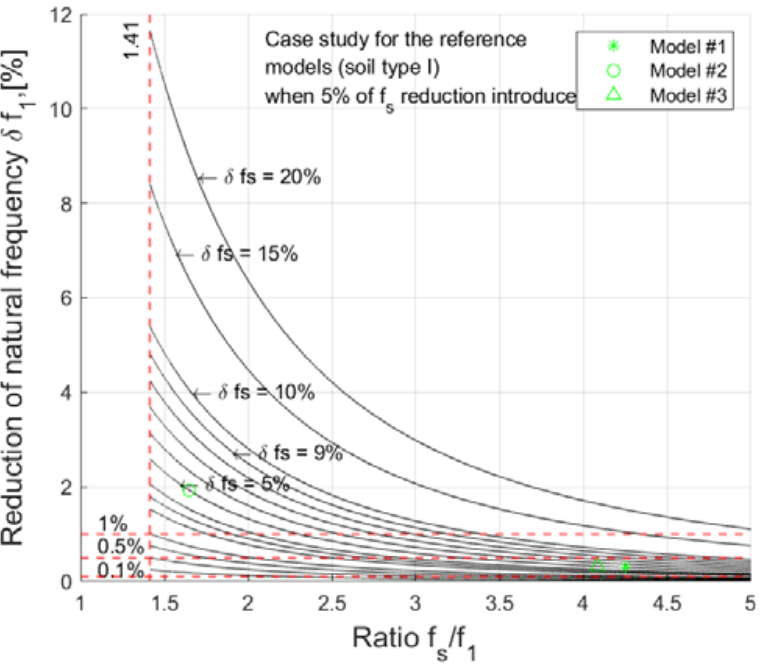
Figure 5. Sensitivity of natural frequency reduction to structural frequency f s reduction.